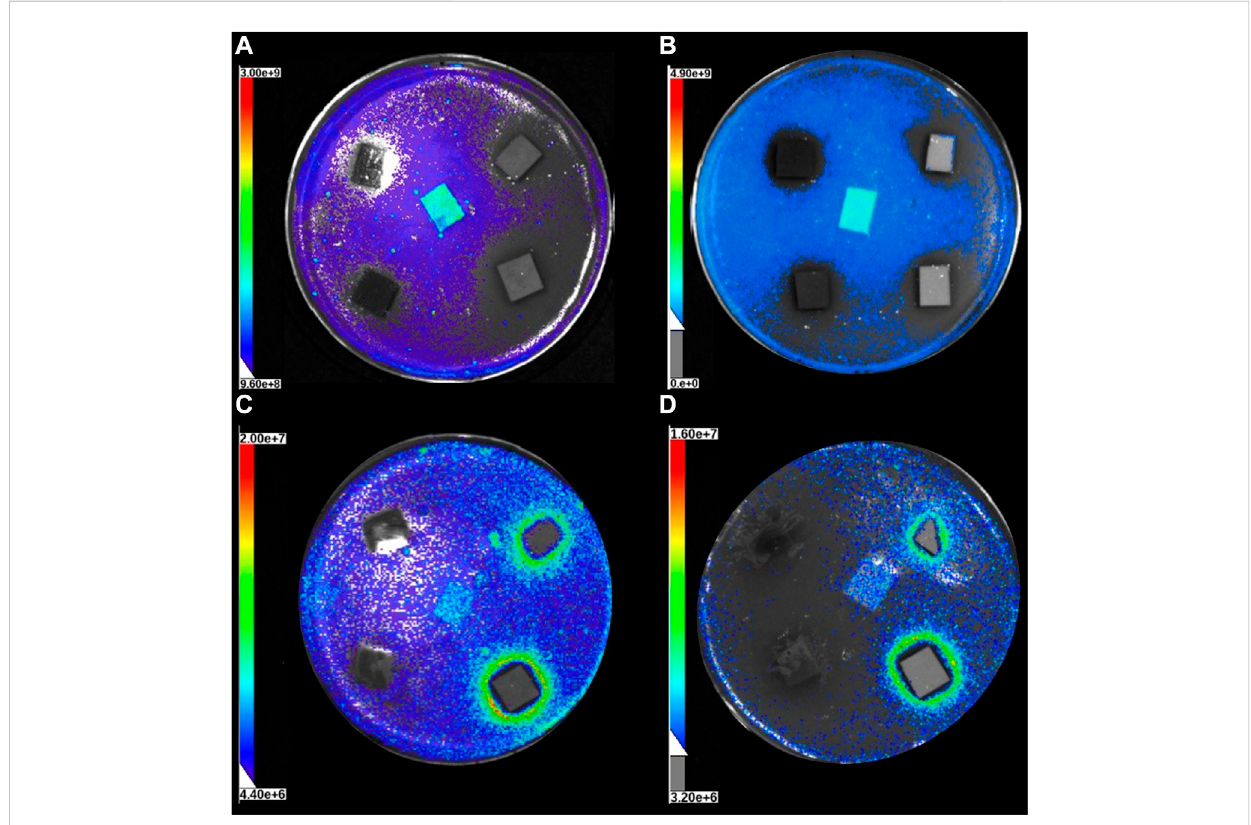
FIGURE 7 The sample papers inPetridisheswith E. coli (A) 60 g/m 2 and (B) 130 g/m 2 and S.aureus (C) 60 g/m 2 ,and (D) 130 g/m 2 imaged with theLago in vivo imaging system in photo overlay mode. As in Figure 6, control or 0-paper is in the middle and others are in clockwise order starting from upright: TA 2%, TA4%,TW 2%,andTW 4%forall theplates (A – D) .Threeidentical Petridisheswerepreparedfor eachsample set,andthecolorscalingontheleftofeach plate indicates the linear luminescence light scaling in units of